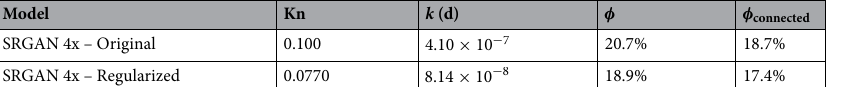
Table 3. Computed flow results. Flow through the generated domains is simulated using LBM simulation. 1 nd ) 2 nd ) Results show permeability values on the order of O ( 10 to O ( 10 , which is the expected order of magnitude for apparent permeability for a shale volume at the rock fabric scale. The permeability computations show that the proposed image translation approach is capable of producing realistic simulation domains for evaluating petrophysical properties from nondestructive image